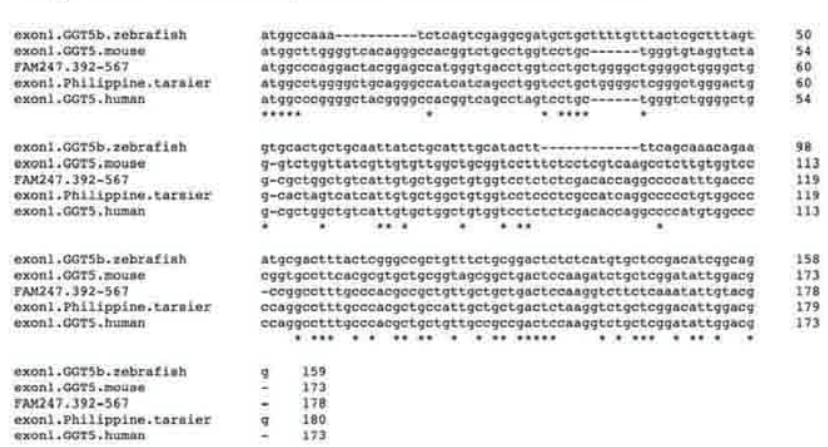
Figure 7. ( Top ) The percent identity of the FAM247 sequence with that of GGT5 exon 1 sequences from four species. Data were obtained using Clustal 2.1. ( Bottom ) Alignment of the GGT5 exon nucleotide sequences from the four species, compared with the FAM247 sequence, positions 192–567. Data were obtained using the EBI Clustal Omega sequence alignment and phylogeny programs. The EMBL-EBI Clustal Omega Multiple Sequence Alignment program [19] is at website http://www.ebi.ac.uk/Tools/msa/clustalo/.